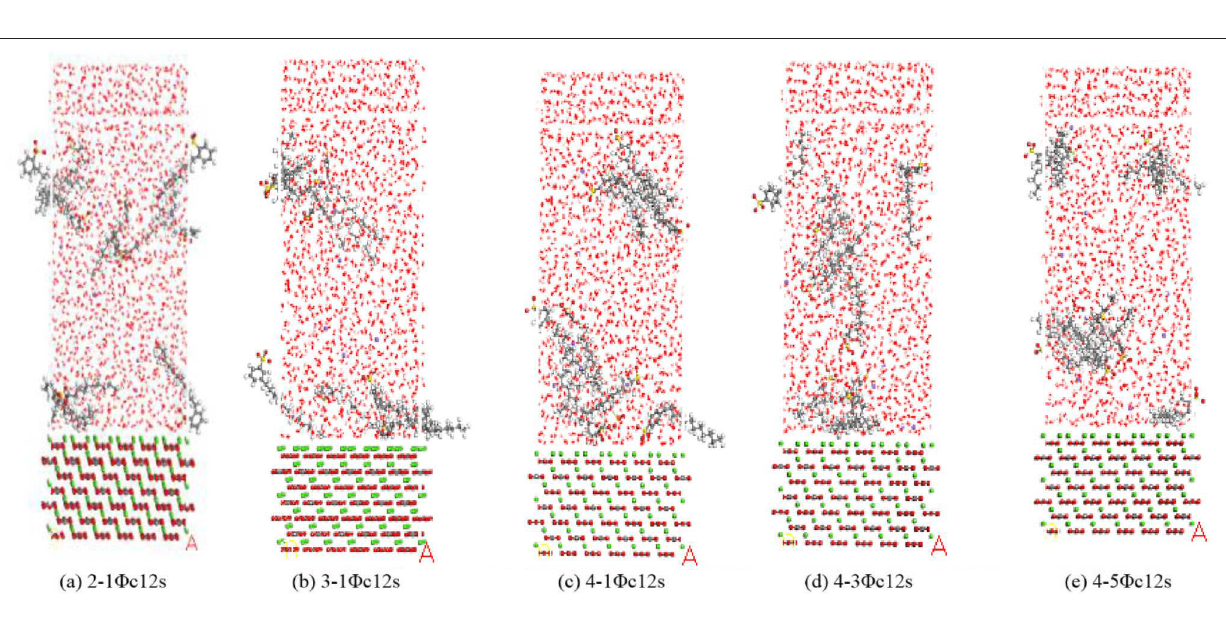
FIGURE 6 | Adsorption of the SDBS and isomers on the CaCO 3